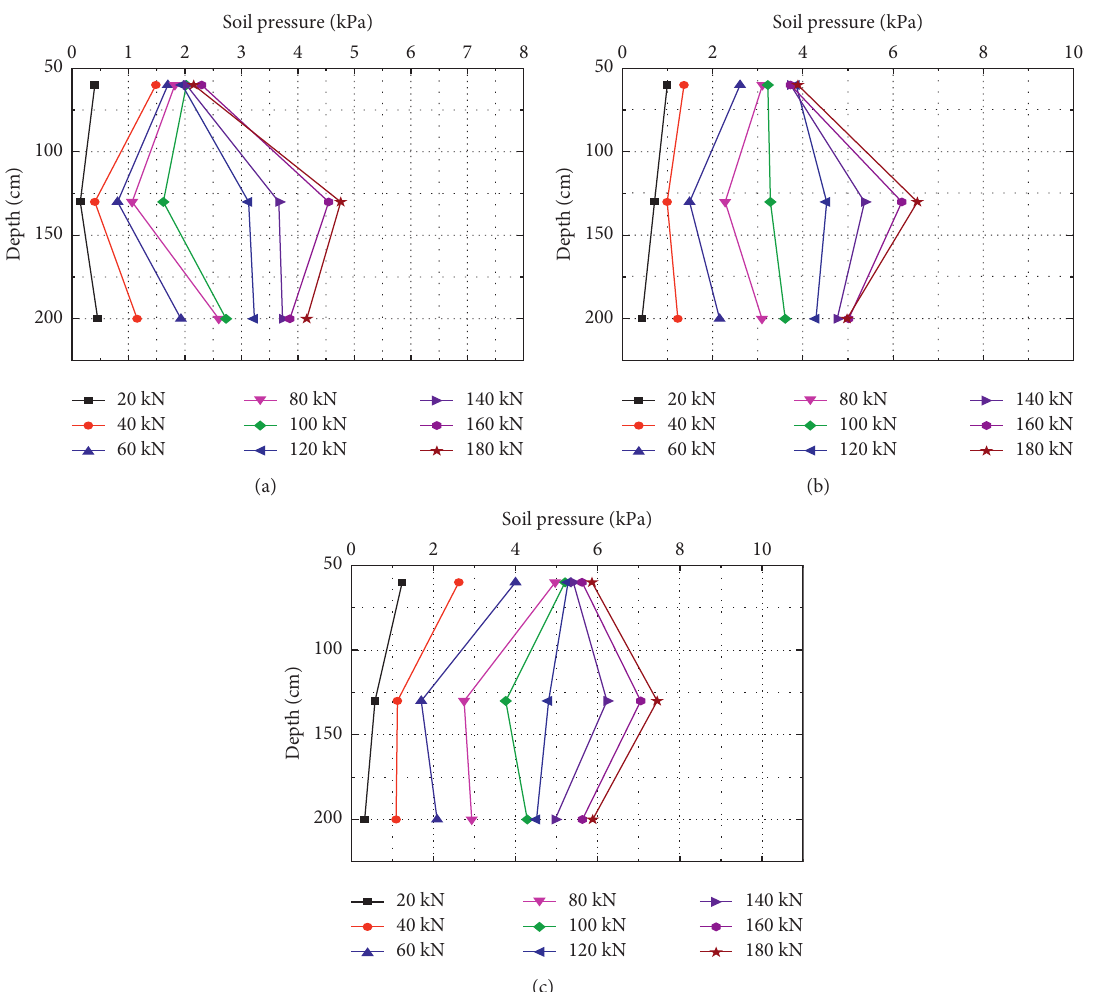
Figure 6: The soil stresses between the piles at different buried depths of the HCPF. (a–c) Different positions of SPTas shown in Figure 1(b).